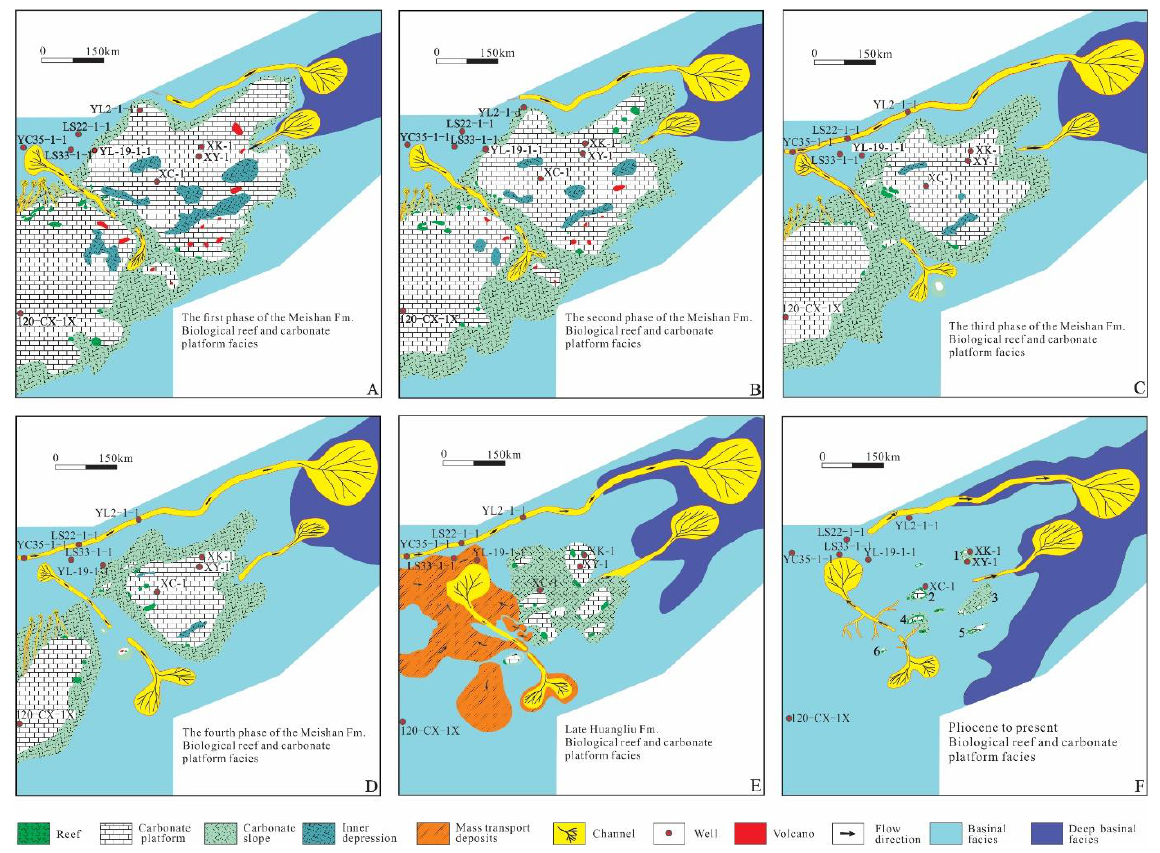
Figure 11. Spatial and temporal distribution of the carbonate platforms in the Xisha sea area (( A , B ) the bloom stage; ( C , D ) the recession stage; ( E ) the submerged stage; ( F ) present).